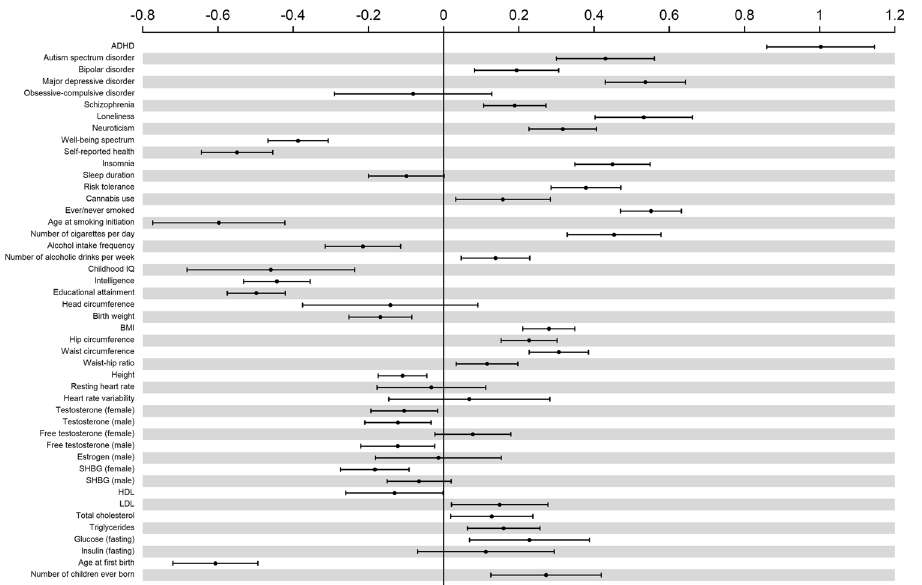
Fig. 4 Genetic correlation with external phenotypes. Phenotypes are ordered by domain. Bars indicate 95% con fi dence